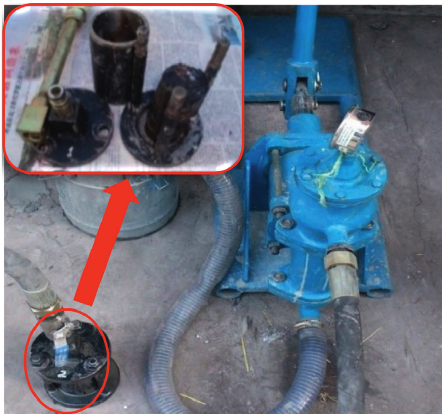
Figure 5: Pressure-bearing grouting